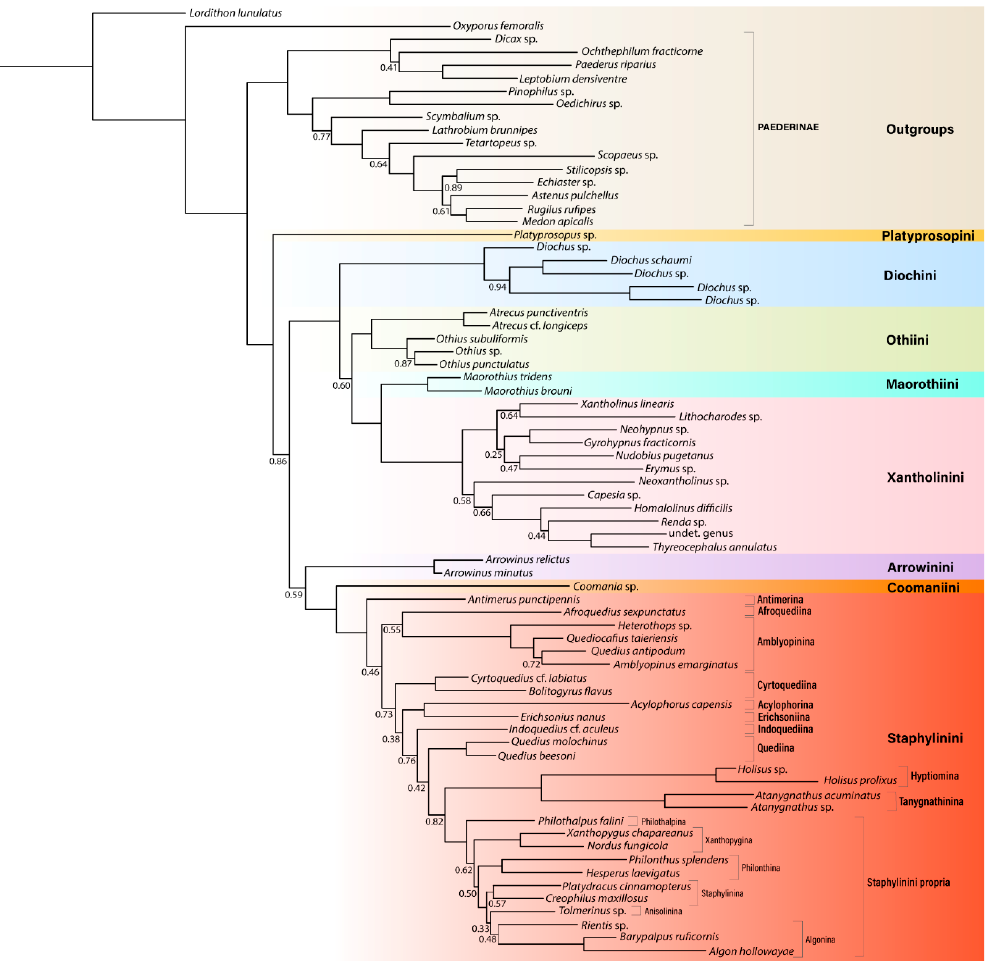
Figure 1. Intertribal relationships within the subfamily Staphylininae based on data from Ż y ł a and Solodovnikov [21] reanalyzed under a site-heterogeneous CAT-GTR model with distantly related outgroups excluded. Unlabeled nodes are strongly supported (BPP ≥ 0.95). Posterior probabilities smaller than 0.95 are reported below each node.